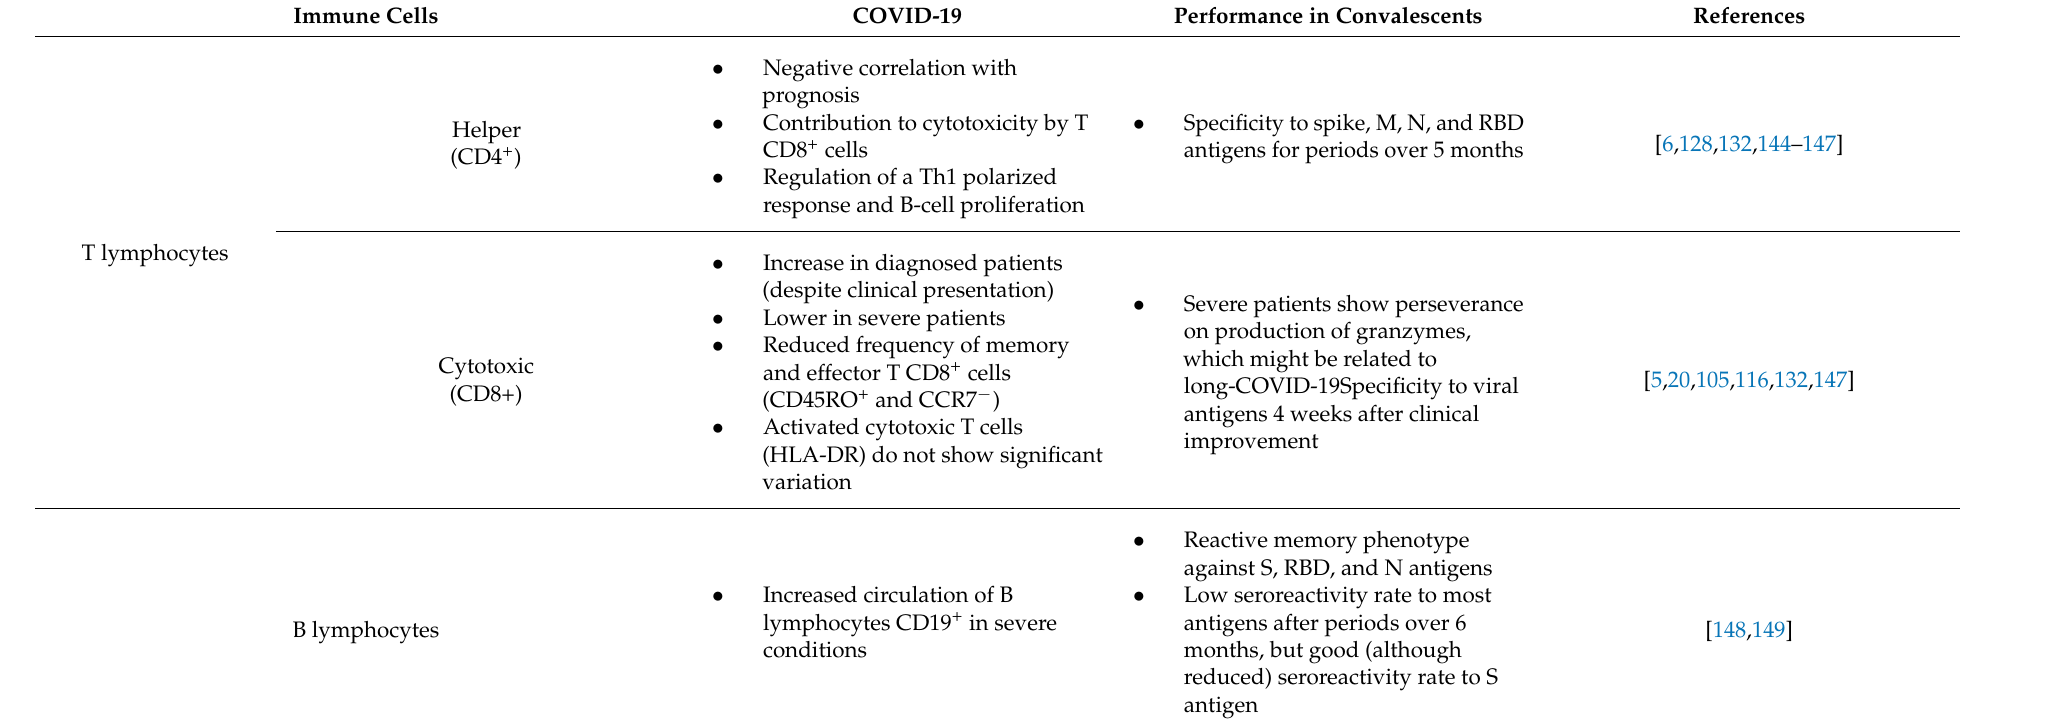
Table 2. Participation of phenotypic and functional lymphocyte cells during COVID-19 disease and